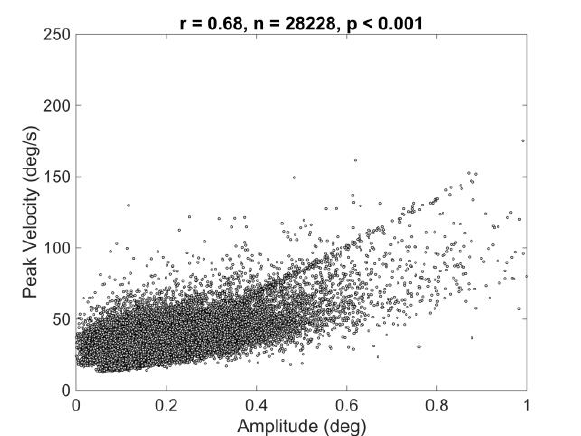
Figure 3 Correlation between microsaccadic ampli- tude and peak